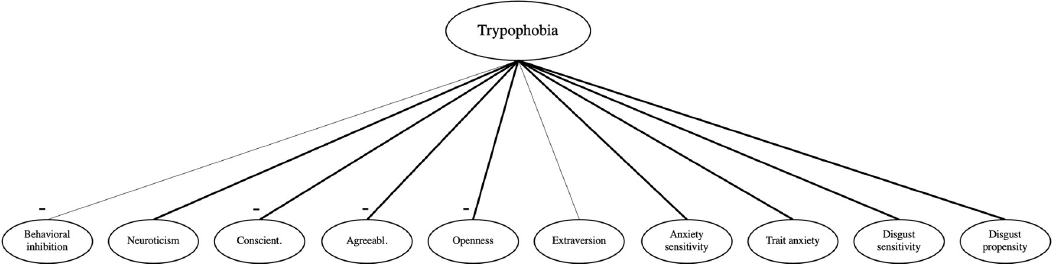
Fig 1. Nomological net of trypophobia. Thicker lines represent associations in common with spider phobia and blood and injection phobia.